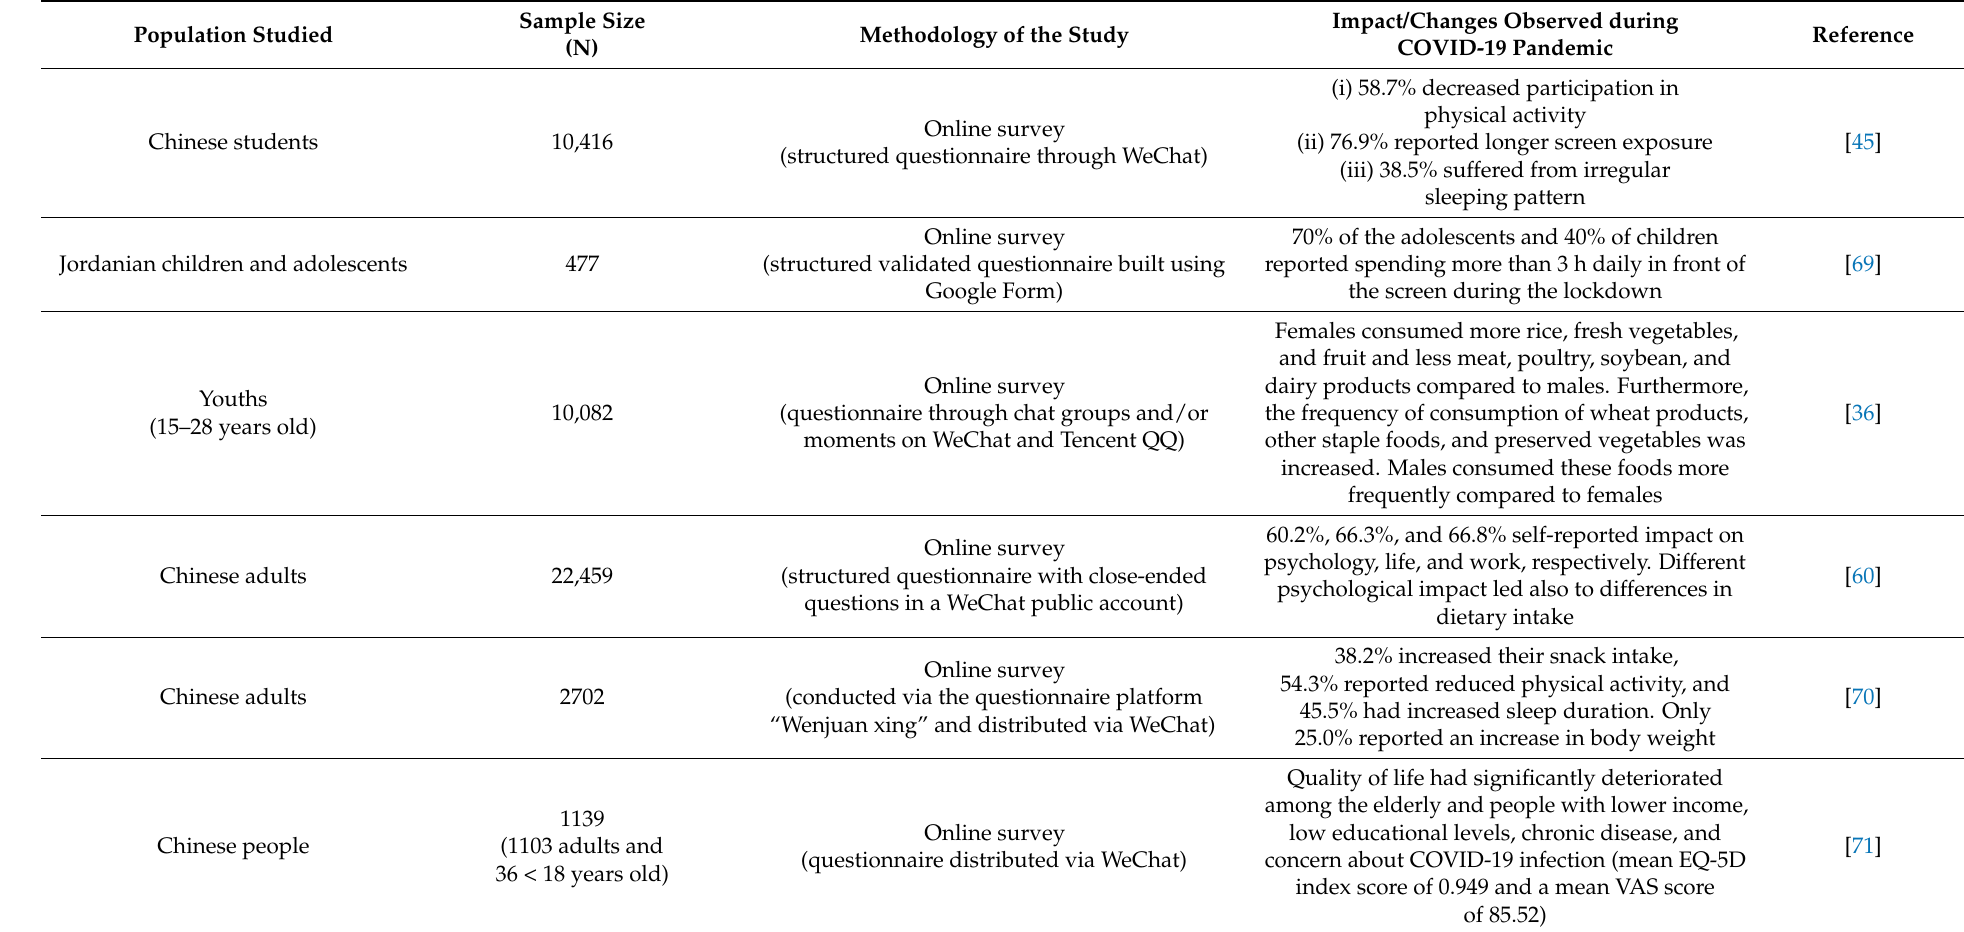
Table 2. Brief summary of studies related to the consequences of the lockdown in Asian